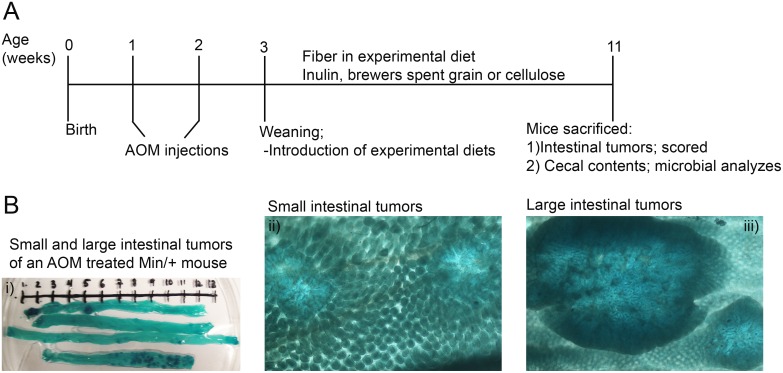
Experimental setup.(A) Timeline. A/J Min/+ mice were injected with azoxymethane (AOM) first one week after birth and secondly one week thereafter. Experimental diets were introduced at three weeks of age, and the mice were fed these diets until they were sacrificed at the age of eleven weeks. The intestines were prepared to score tumors and cecal contents collected for microbial analyzes. (B) Intestines from an AOM treated A/J Min/+ mouse stained in 0.2% methylene blue. Tumors were predominantly formed in the colon (i). Example of the tumor morphology of the small (ii) and large intestinal tumors (iii).